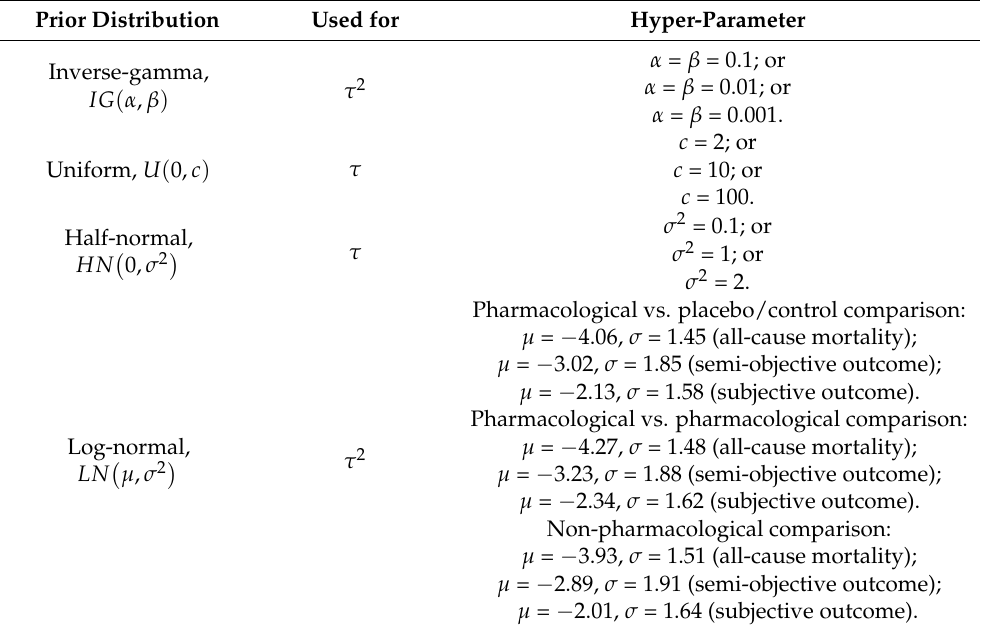
Table 1. Summary of prior distributions for the heterogeneity component (variance τ 2 or standard deviation τ ) in a meta-analysis of odds